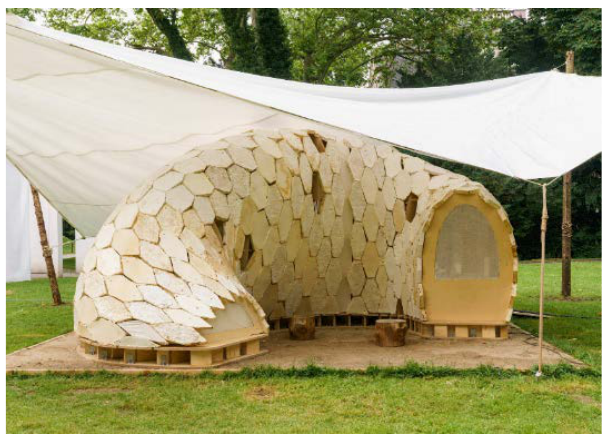
Figure 15 MY-CO-X-2021 (Url-19).